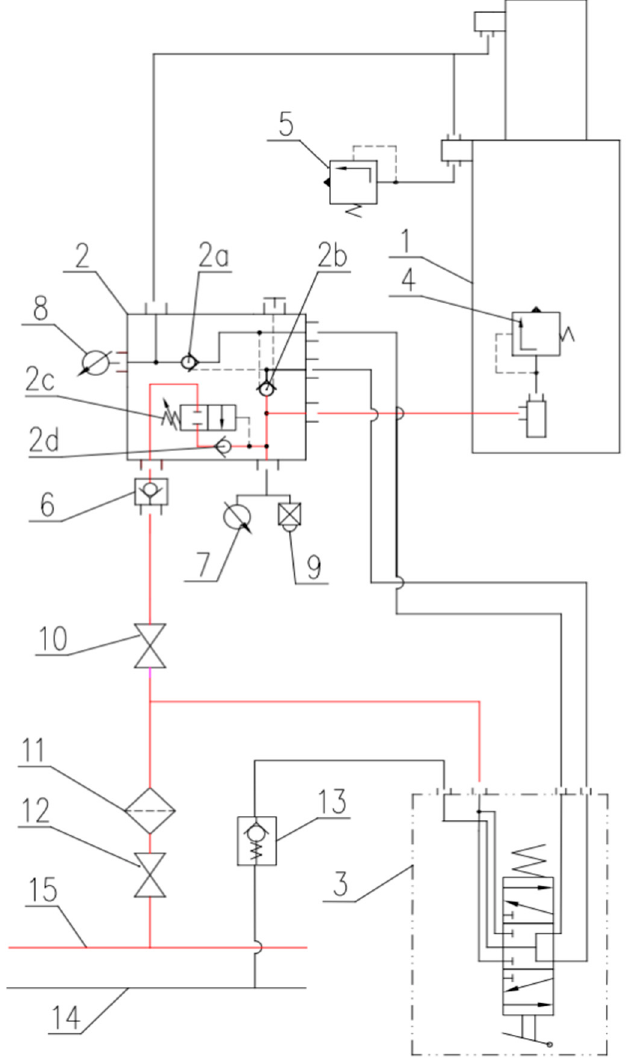
Figure 3. Conception of the hydraulic system for the automatic expansion of powered roof support: 1, leg; 2, valve block with double function of expanding the leg; 3, four-way distributor; 4, and; 5, safety valve; 7, and; 8, manometer; 9, pressure indicator; 10, and; 12, shut-off valve; 11, filter; 13, check valve; 14, runoff line; 15, power bus.